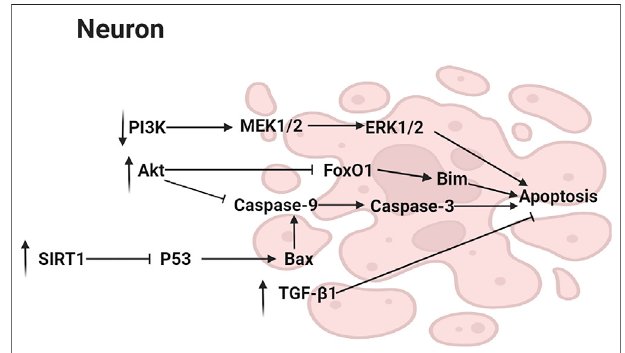
FIGURE 4 | Mechanisms involved in the suppression of apoptosis by neolignans.